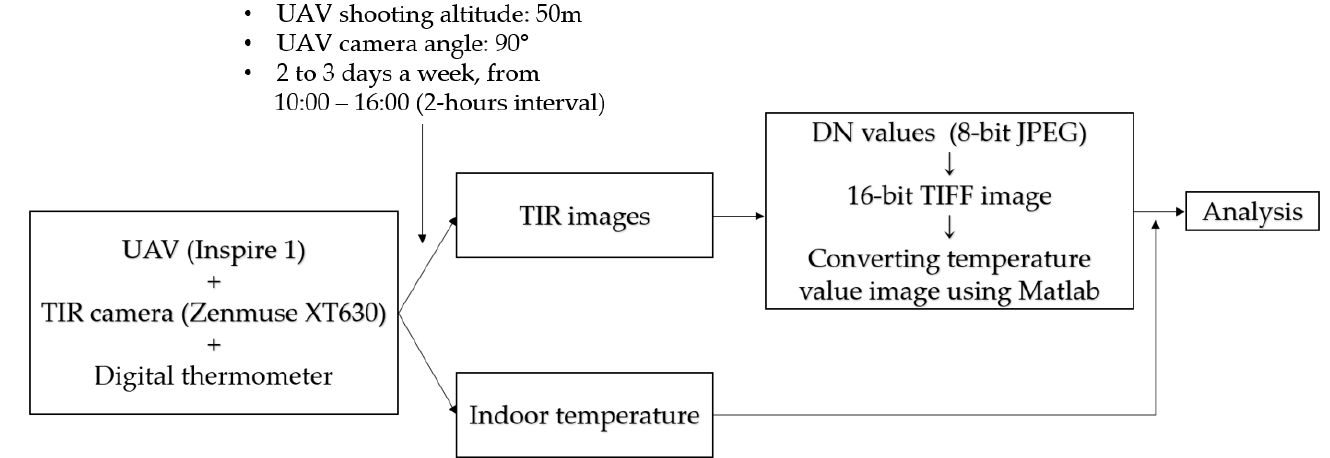
Figure 4. Surface temperature and indoor temperature data acquisition process.